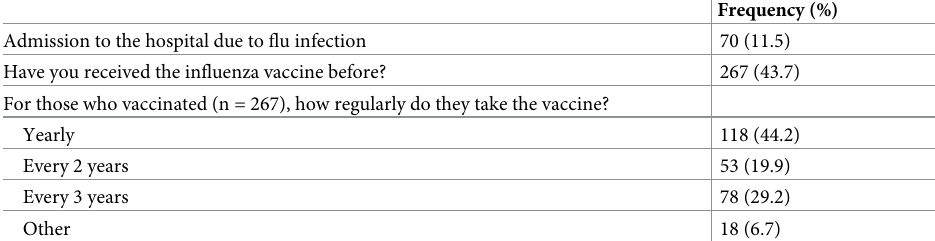
Table 6. The previous history concerning hospitalization due to flu infection, receiving a flu vaccination, and fre- quency of vaccination (total number = 611, ever vaccinated = 267).